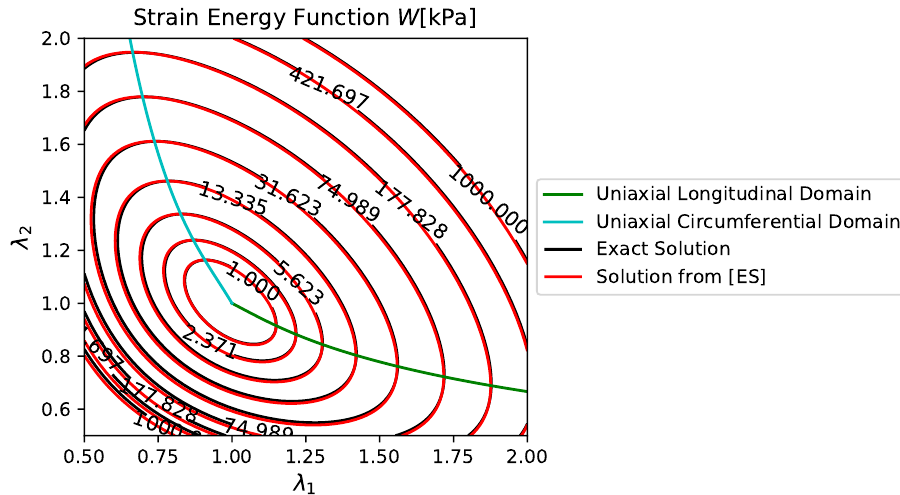
Figure 10. Exact solution and the solution obtained with ES